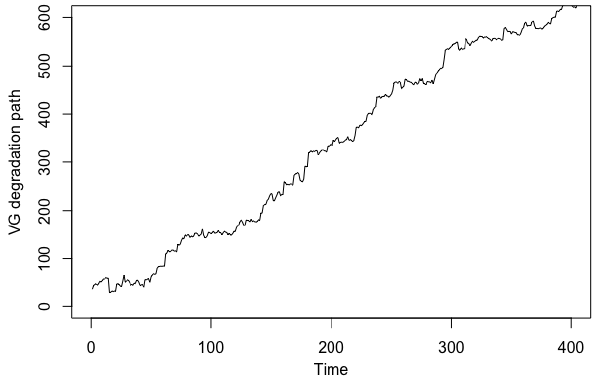
Figure 1. Variance gamma sample